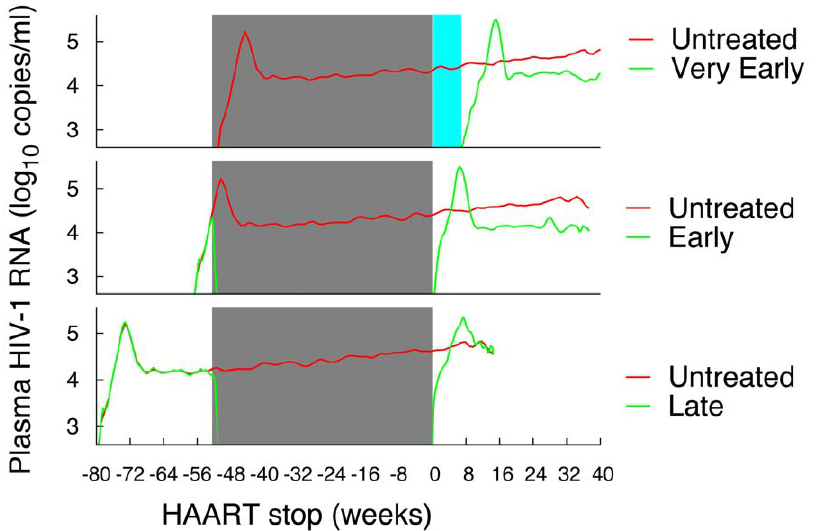
Figure 1. Simulations of treated and untreated case. Comparing simulations of the treated and untreated cases. All simulations share the same parameter settings with the only difference that therapy starts at day 0 in the very-early , at day 40 in the early and at day 200 in the late settings. The duration of simulated therapy is one year.